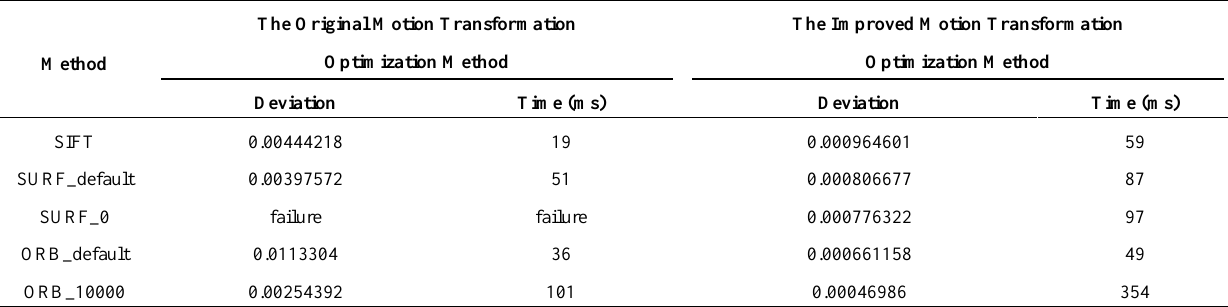
Table 6. Results for motion transformation optimization